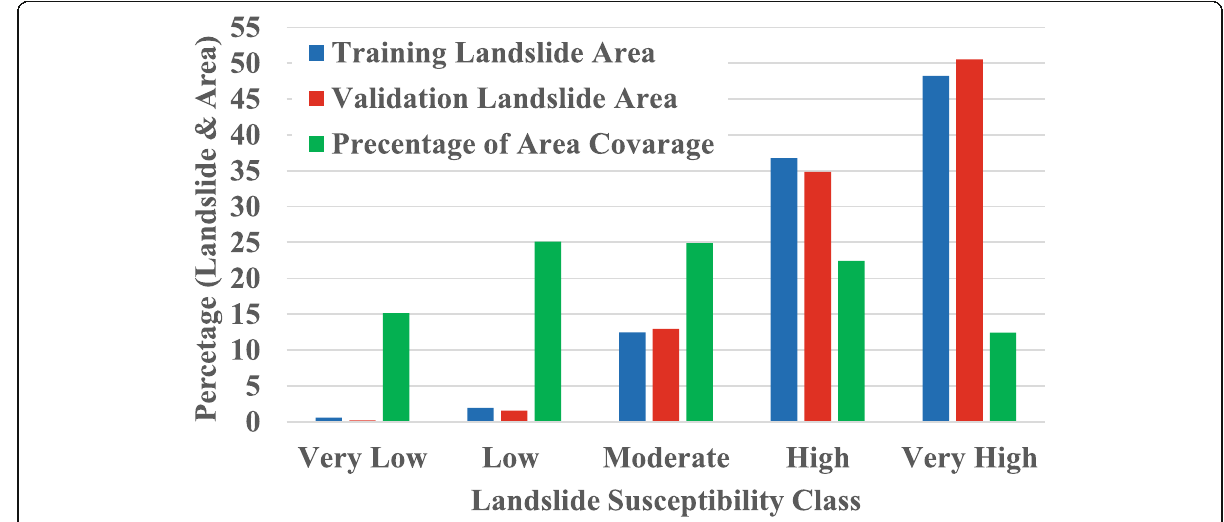
Fig. 11 Bar graph showing validation of the model using landslide density